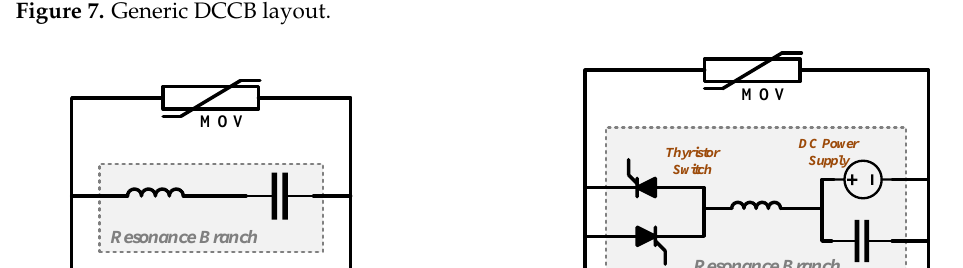
Figure 7. Generic DCCB layout.